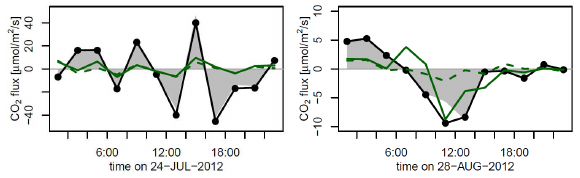
2.7 ± 1.1 µmol (m 2 s) − 1 CO 2 for the nighttime from 23:00 to 04:00 in the years